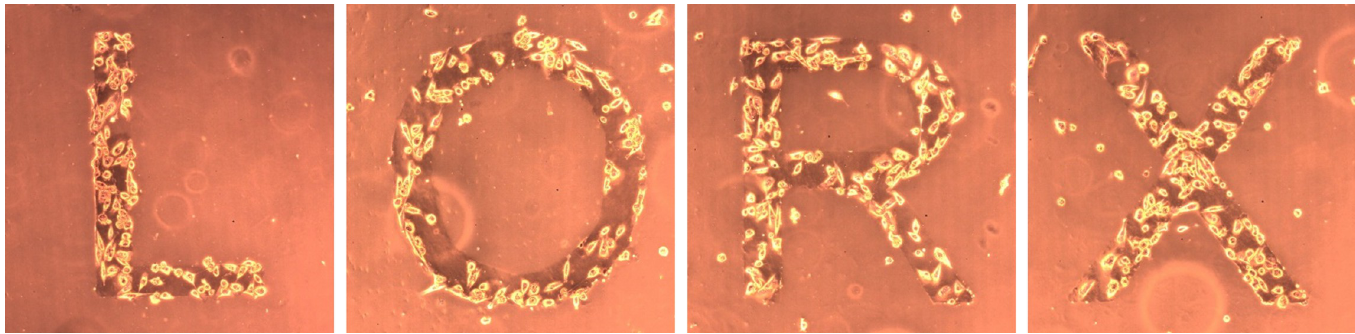
Fig 7. MDA-MB-231 cancer cells patterning in the shape of different alphabet letters. The cells were cultured on GO-coated COC substrates in which the letters were made hydrophilic using GO and the rest of the substrate was hydrophobic by nature.